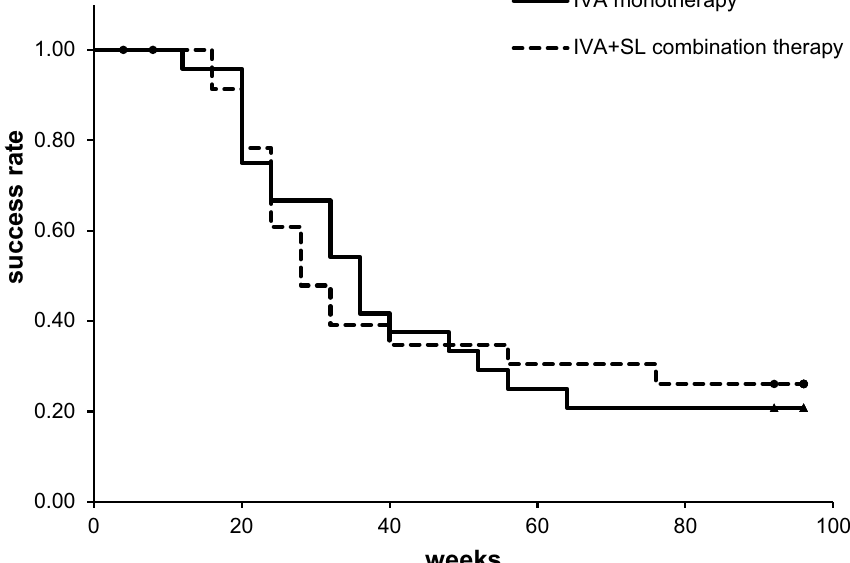
Figure 2. Kaplan–Meier survival curve analysis of IVA monotherapy group (n = 24) and IVA + SL combination group (n = 25) which classified retreatment due to recurrence of ME as a failure. IVA intravitreal injection of aflibercept; SL subthreshold laser.